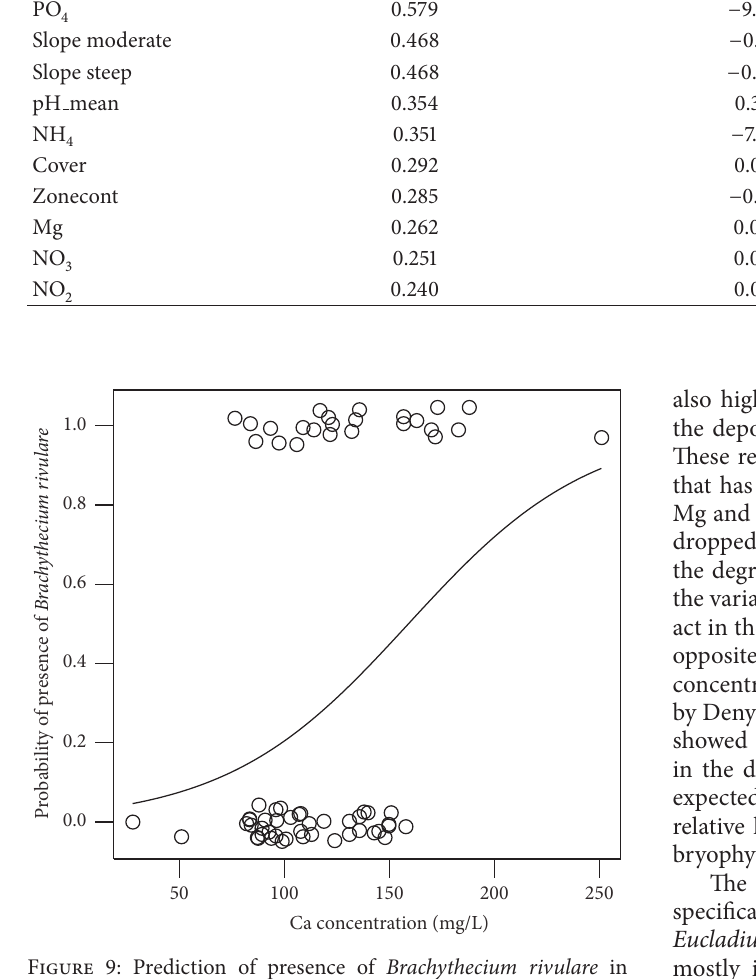
Figure 9: Prediction of presence of Brachythecium rivulare in relation to Ca concentration based on the coefficients of the best models selected by AIC stepwise